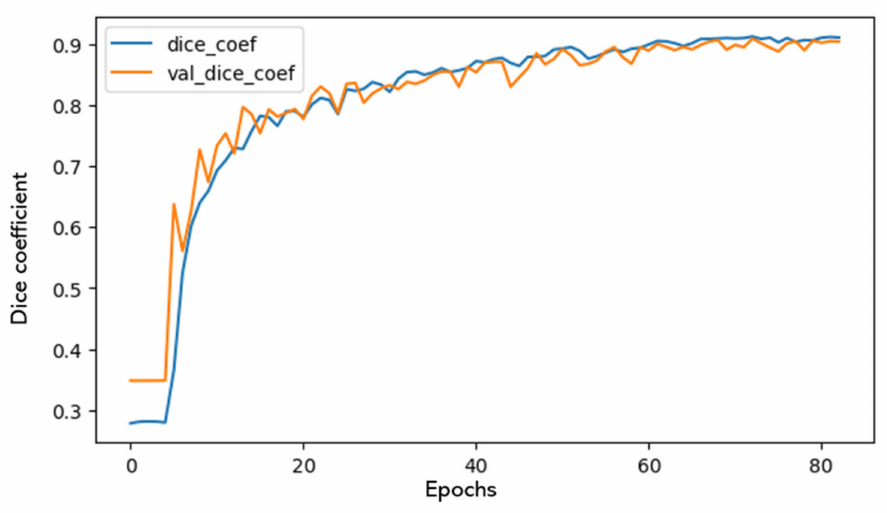
Figure 5. Learning plot with training and validation